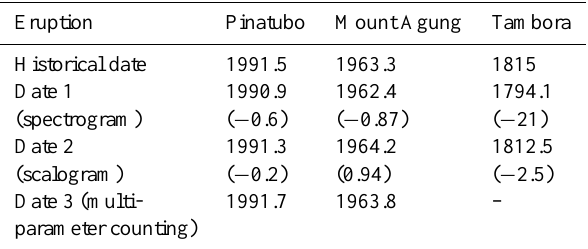
Table 1. Dating of tie points issued from the spectrogram and the scalogram, and published by de Angelis et al. (2003). Differences in Tambora eruption dates may be due to the fact that this eruption is located in the aliased part of the data or due to inaccurate eruption identification.